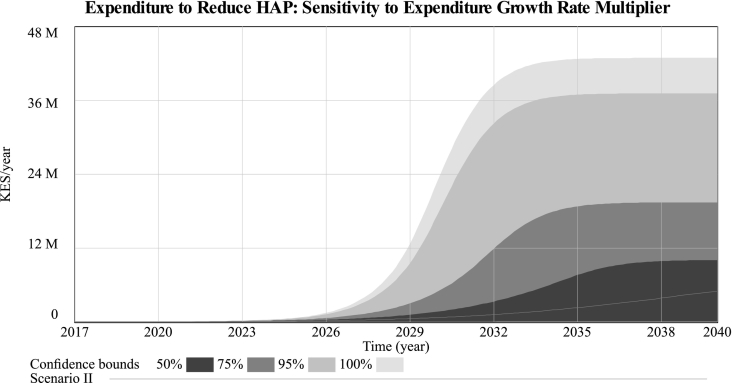
Sensitivity of expenditure to reduce household air pollution to expenditure growth rate multiplier.